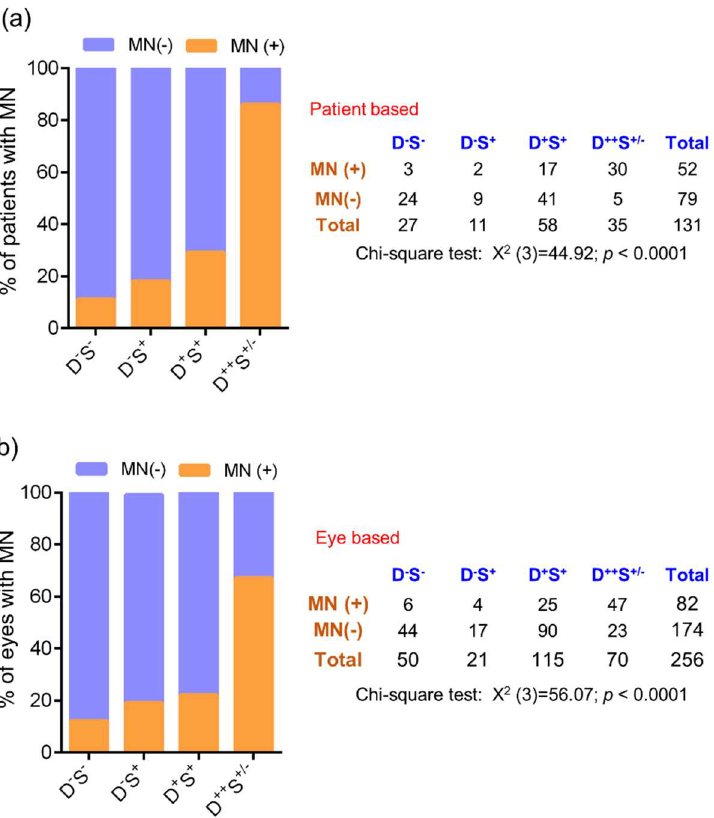
Figure 5. Frequency of microneuroma-like structures in subjects categorized based on discomfort concordance to signs (DCS) grouping strategy. Stacked bar graphs represent ( a ) percentage of patients with and without microneuroma-like structures determined in laser scanning in vivo confocal microscopy images in the different groups. The adjacent table provides the absolute number of patients with and without microneuroma-like structures in the different groups. ( b ) percentage of eyes with and without microneuroma- like structures determined in laser scanning in vivo confocal microscopy images in the different groups. The adjacent table provides the absolute number of eyes with and without microneuroma-like structures in the different groups. Chi-square test was performed to determine the statistical significance of the difference in the frequency of microneuroma-like structures between the groups. p < 0.05 is considered to be statistically significant. MN—microneuroma-like structures.